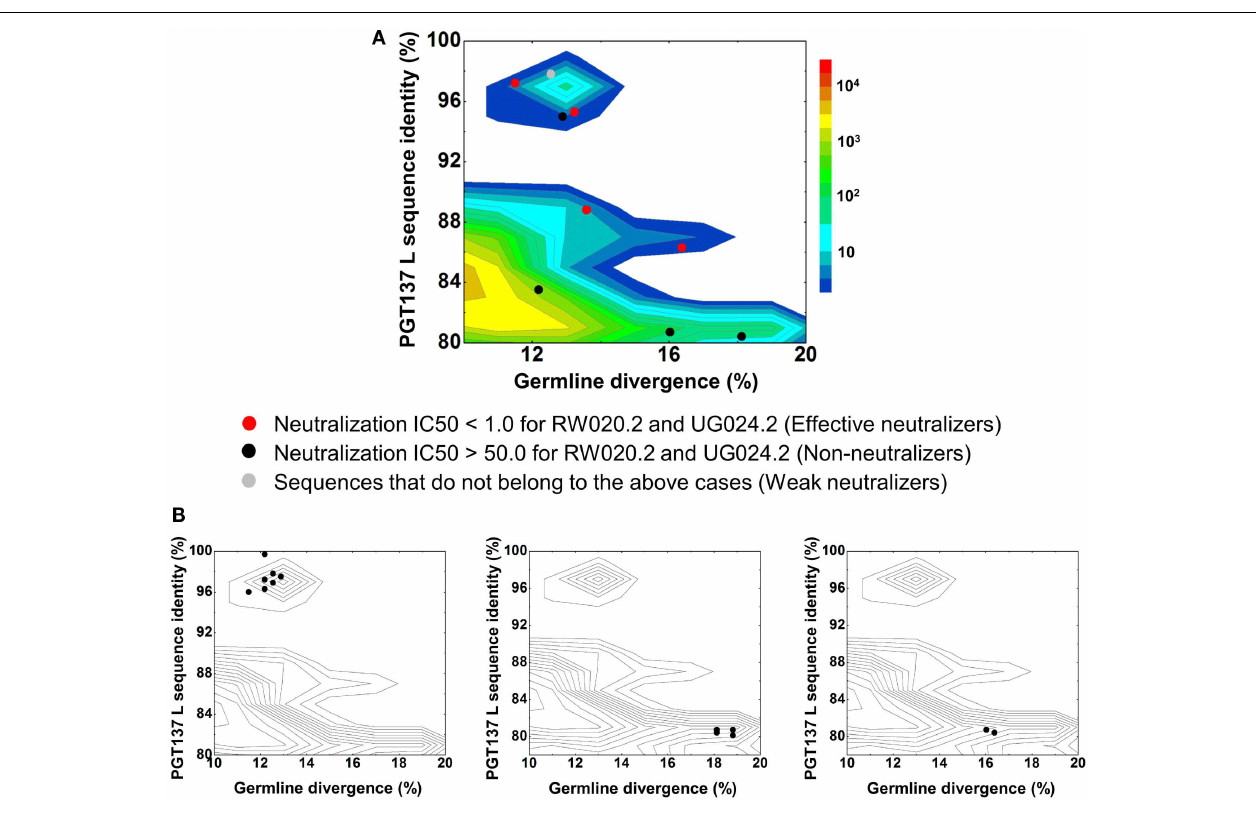
> 50.0 for both viruses in black (non-neutralizers), and other cases in gray (weak neutralizers). (B) The three largest clusters are displayed on the enlarged divergence/identity plot, with 45, 6, and 4 members, respectively.